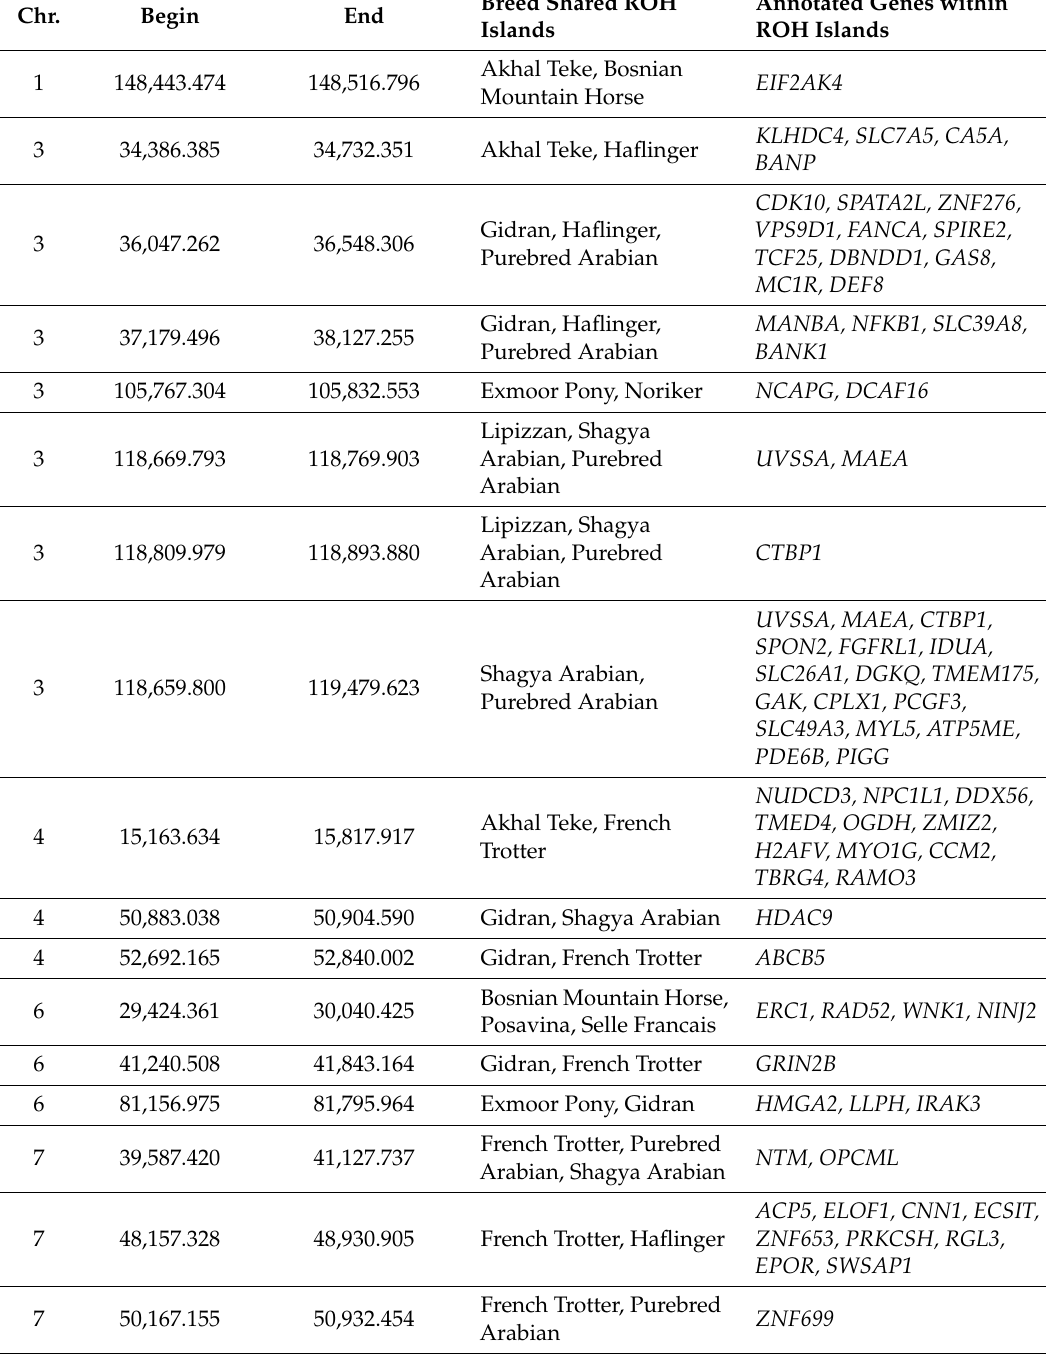
Table 3. Overlaps of runs of homozygosity (ROH) islands (begin and end in Mb) between breeds and annotated